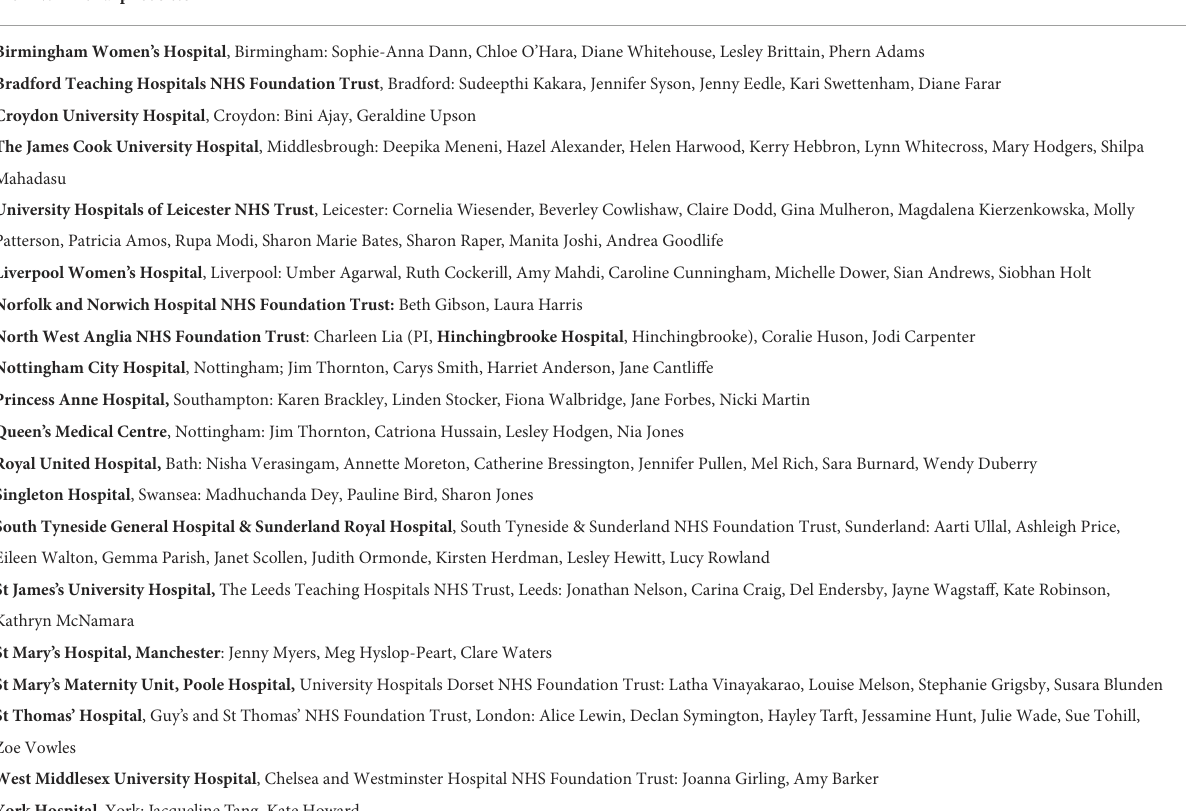
TABLE A1 WILL Pilot Trial Study